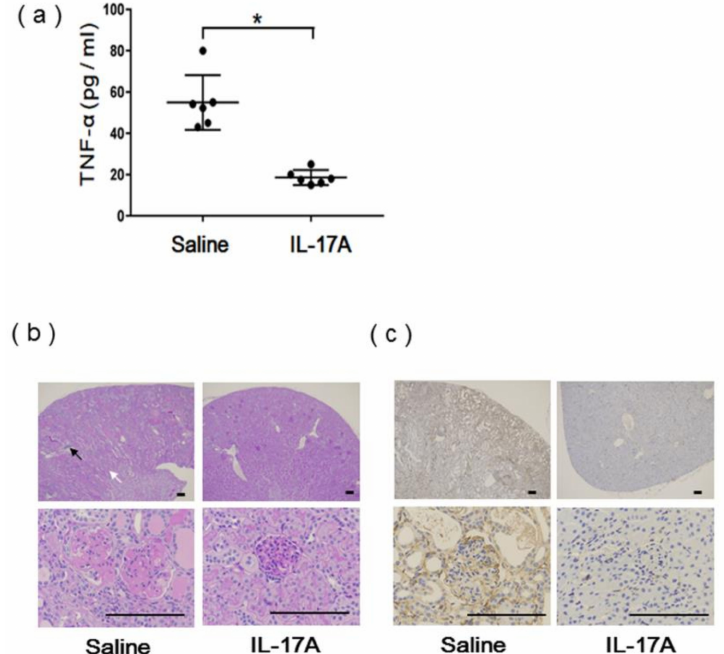
Figure4. SerumcytokinesinvaccinatedNZBWF1mice; ( a )SerumTNF- α concentrationwassignificantly decreased in IL-17A vaccine group 34 weeks after the first vaccination; * p < 0.05 vs. saline group; n = 5. ( b ) Periodic acid Schi ff (PAS) staining of kidney sections from IL-17A vaccine group (right) and saline group (left). Glomerulosclerosis, glomerular necrosis, tubular atrophy (white arrow), and vasculitis (black arrow) were suppressed in IL-17A vaccine group 36 weeks after first vaccination. Scale bar = 100 µ m. ( c ) F4 / 80 immunostaining of kidney sections from IL-17A vaccine group (right) and saline group (left). Infiltration of macrophages was suppressed in IL-17A vaccine group 36 weeks after first vaccination. Scale bar = 100 µ